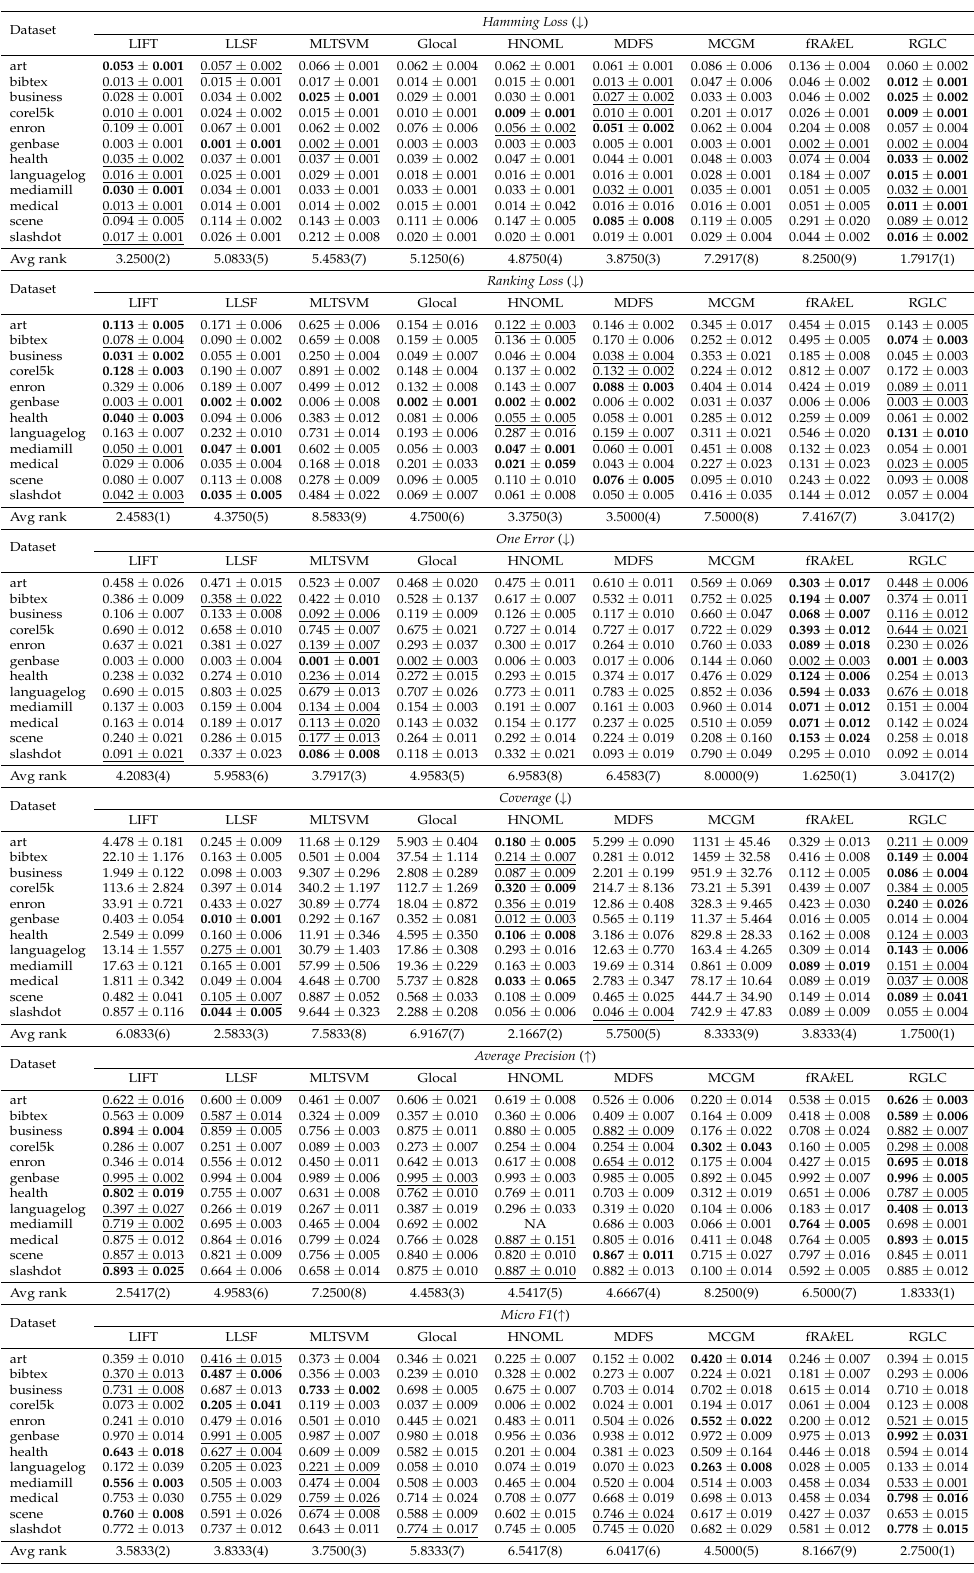
Table 2. Comparison of each algorithm (mean ± std). Best results and second best are in bold and underlined, respectively. ( ↓ the smaller the better, ↑ the larger the